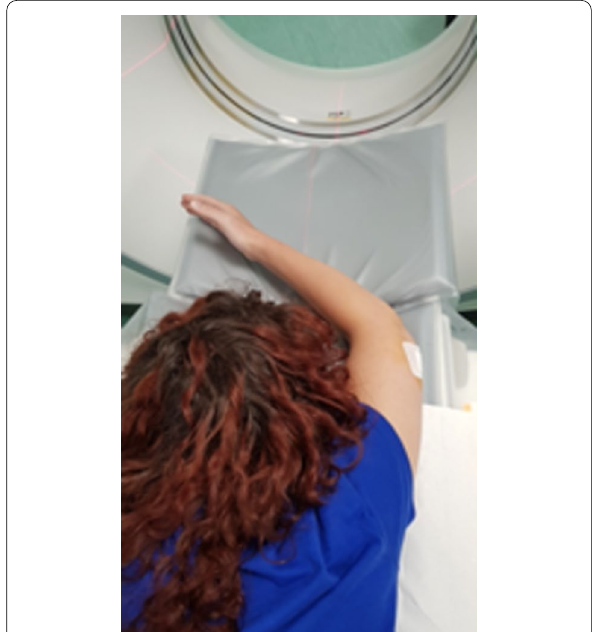
Fig. 4 The patient is positioned prone on the CT scanning table, with the affected upper limb elevated over the head and with a 45° flexion of the